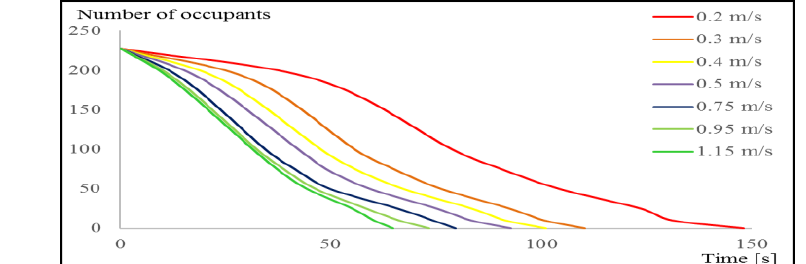
Figure 16 – Simulation results for the fastest times of the fourth case of the second